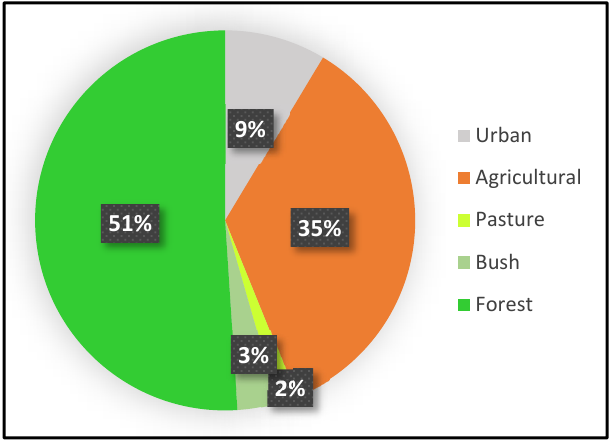
Figure 5. The percentage of ignitions per land use class.